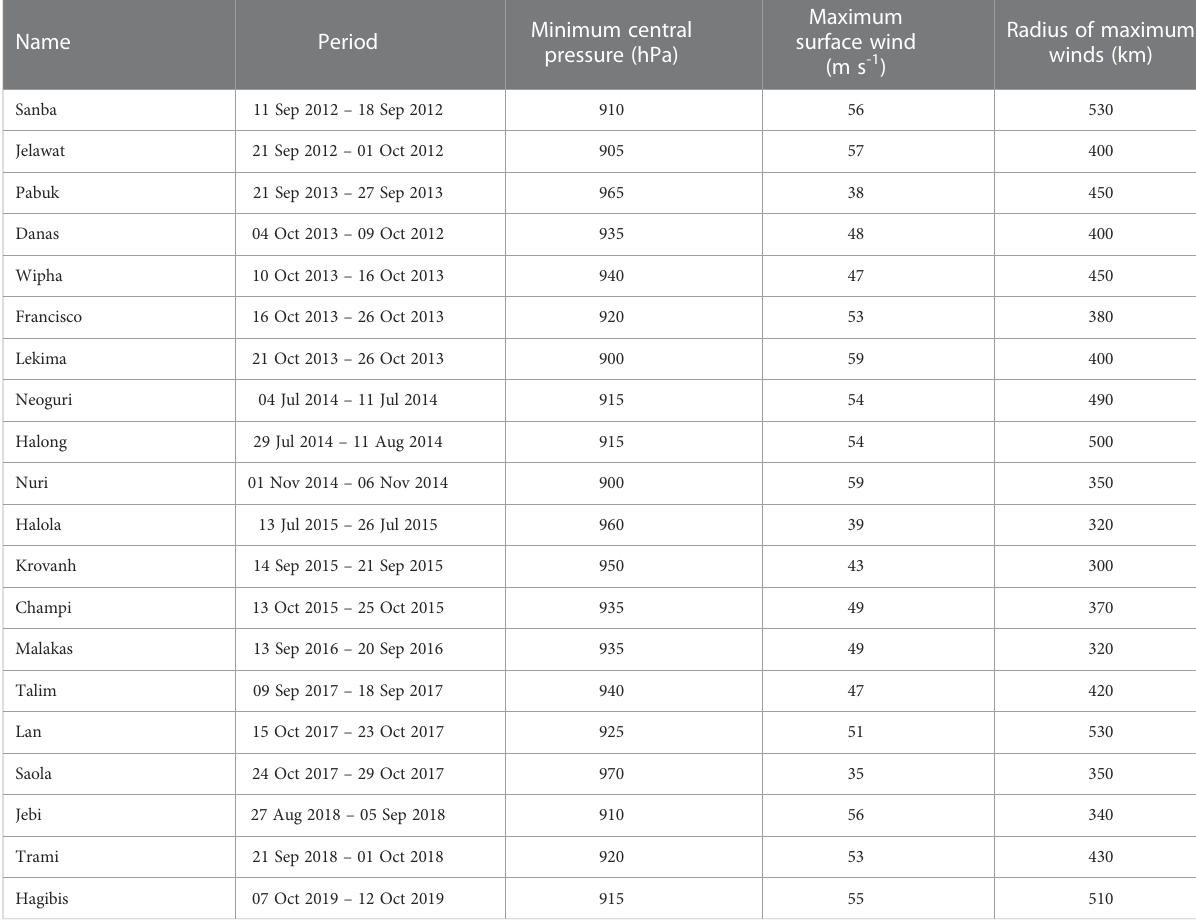
TABLE 1 Information of the typhoons used in this study in the Northwest Paci fi c from Aquarius and Soil Moisture Active Passive (SMAP) satellites during 2011 to